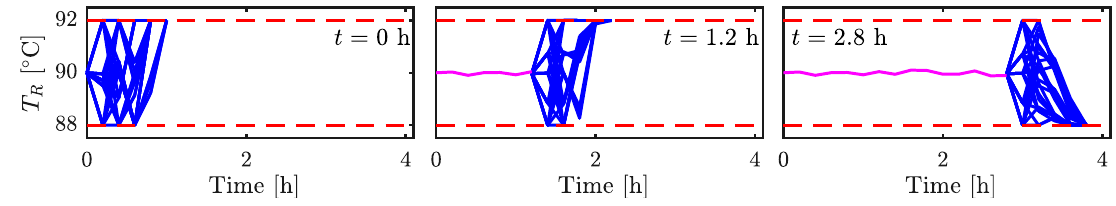
Figure 15. Reactor temperature predicted in the scenario tree of the MS-VA NMPC optimization problems solved at t = 0 h, t = 1.2 h and t = 2.8 h. The magenta line ( ) indicates the measured reactor temperature and control inputs applied to the plant until time t , the blue lines ( ) indicate the predicted plant states and control inputs and the dashed red lines ( ) indicate the constraints.